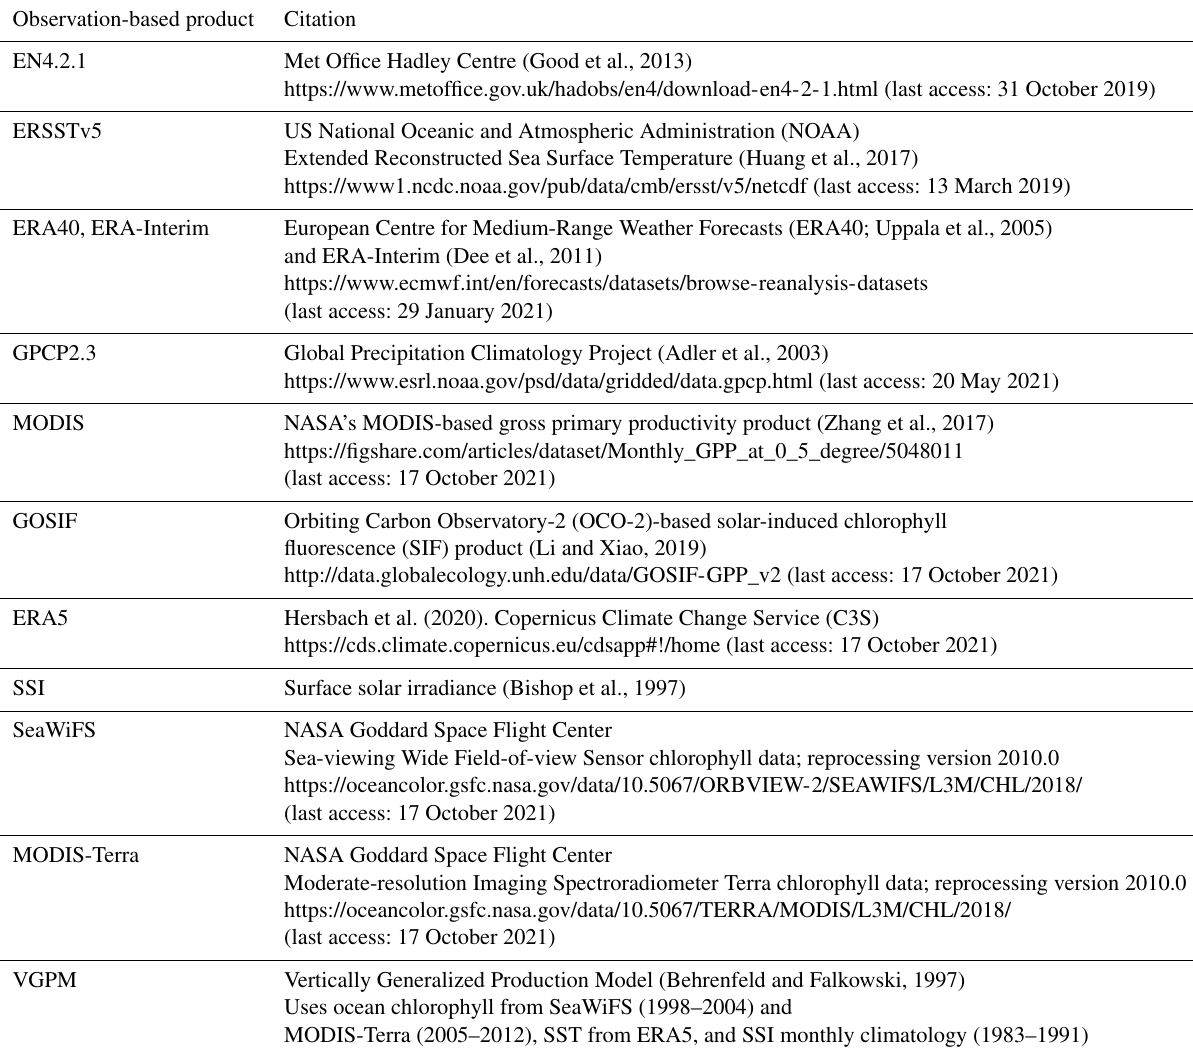
Table B2. List of observation-based products. Observation-based